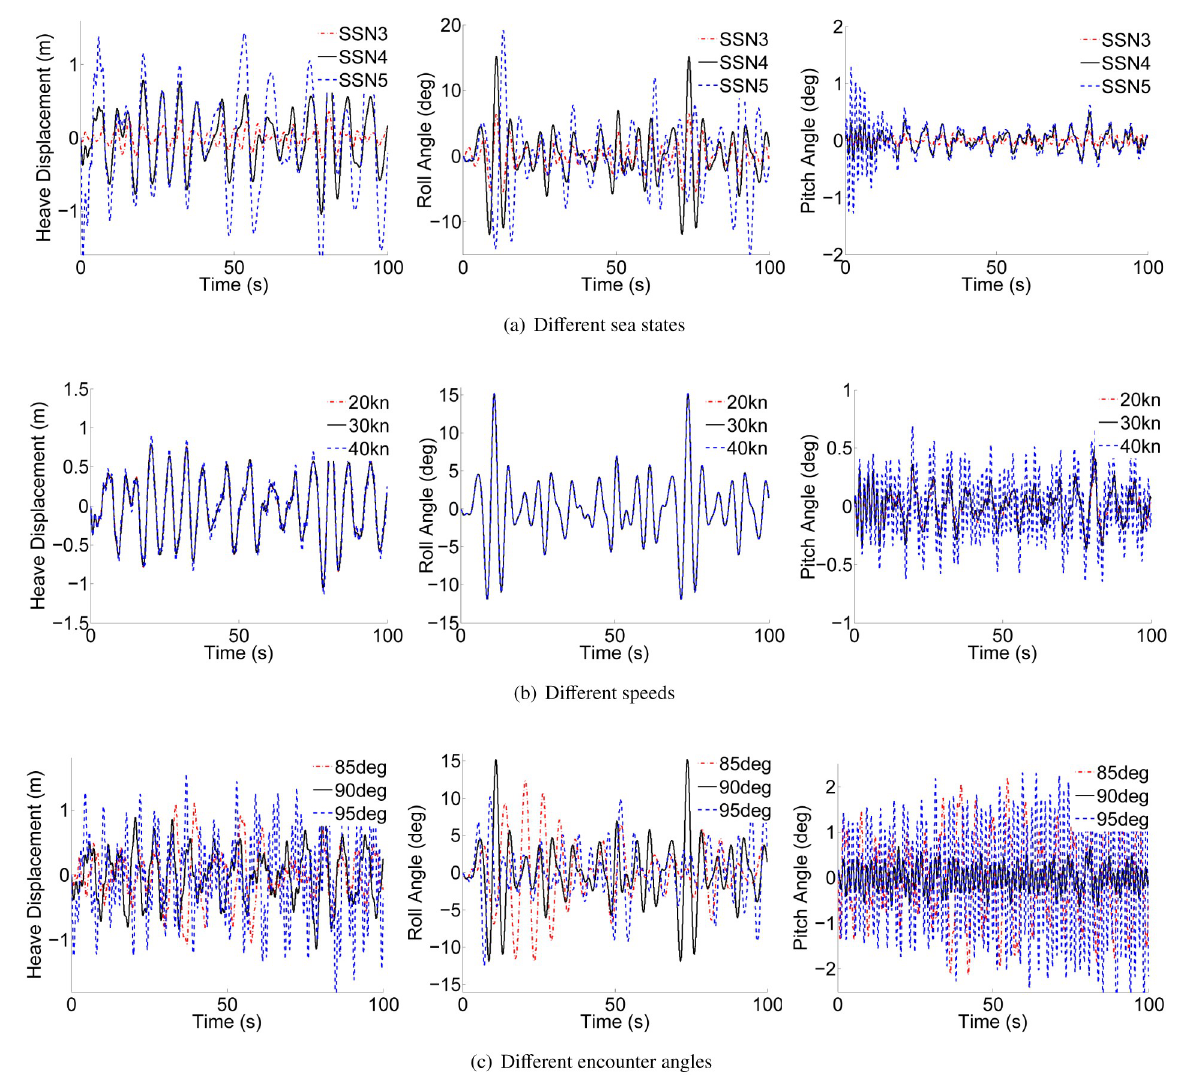
Fig 13. Vibration of the WPC vessel without proposed controller in different situations. (a) Different sea states. (b) Different speeds. (c) Different encounter